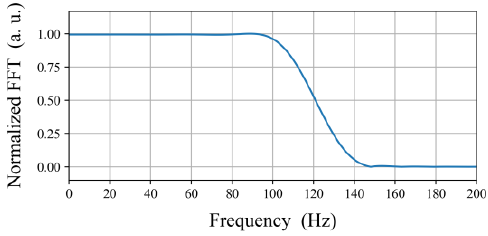
Figure 5. LUT values of the oscillator cos𝜔 0 implemented in VHDL.